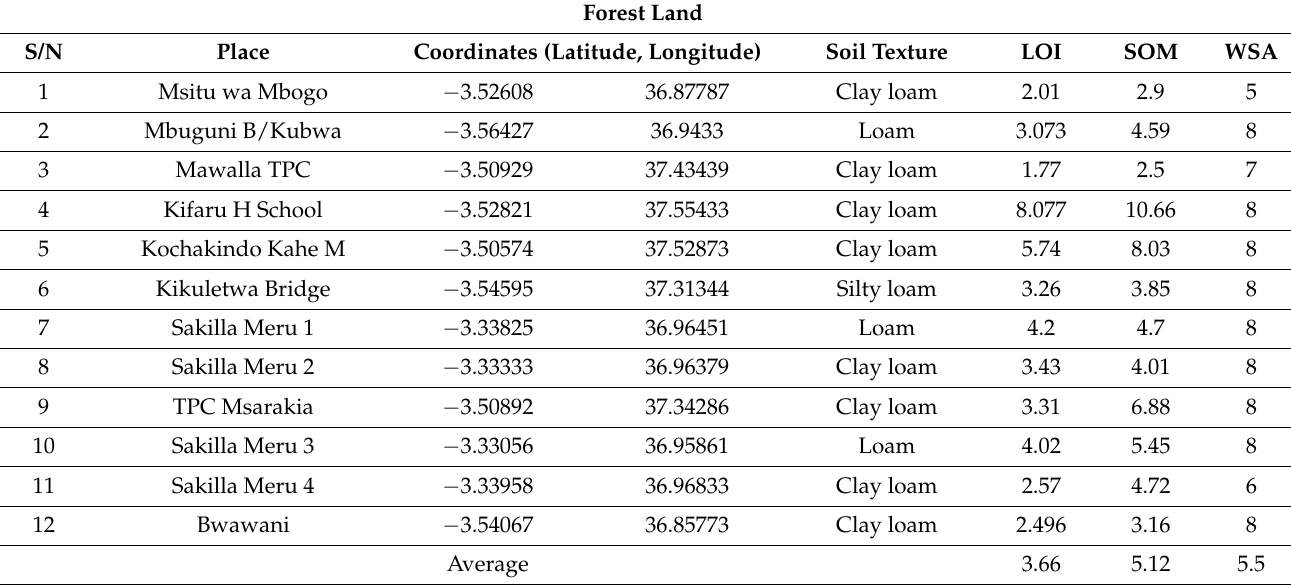
Table A1. LOI: SOM and WSA from different LU classes. Forest